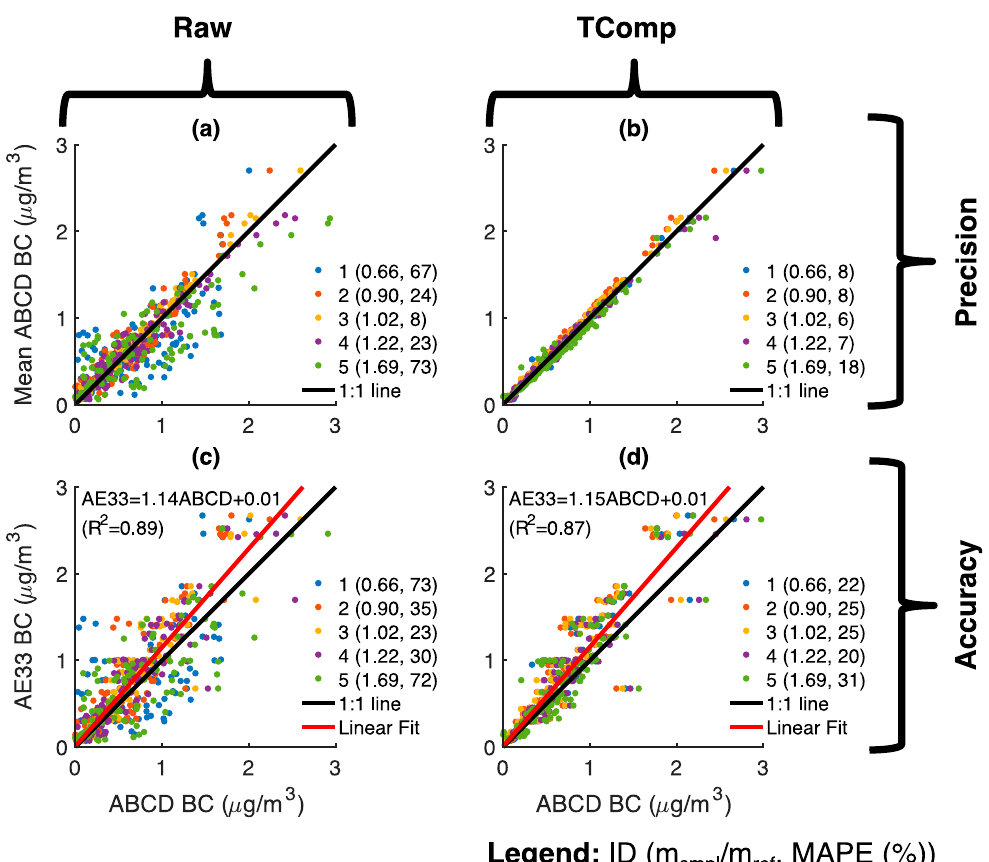
Figure 10. Five ABCD units operating atop a Bay Area Air Quality Management District near-roadway monitoring station: ( a ) Precision of uncompensated (Raw) black carbon (BC) concentrations; ( b ) Precision of temperature-compensated (TComp) BC concentrations; ( c ) Accuracy of uncompensated BC concentrations; ( d ) Accuracy of temperature-compensated BC concentrations. All data is